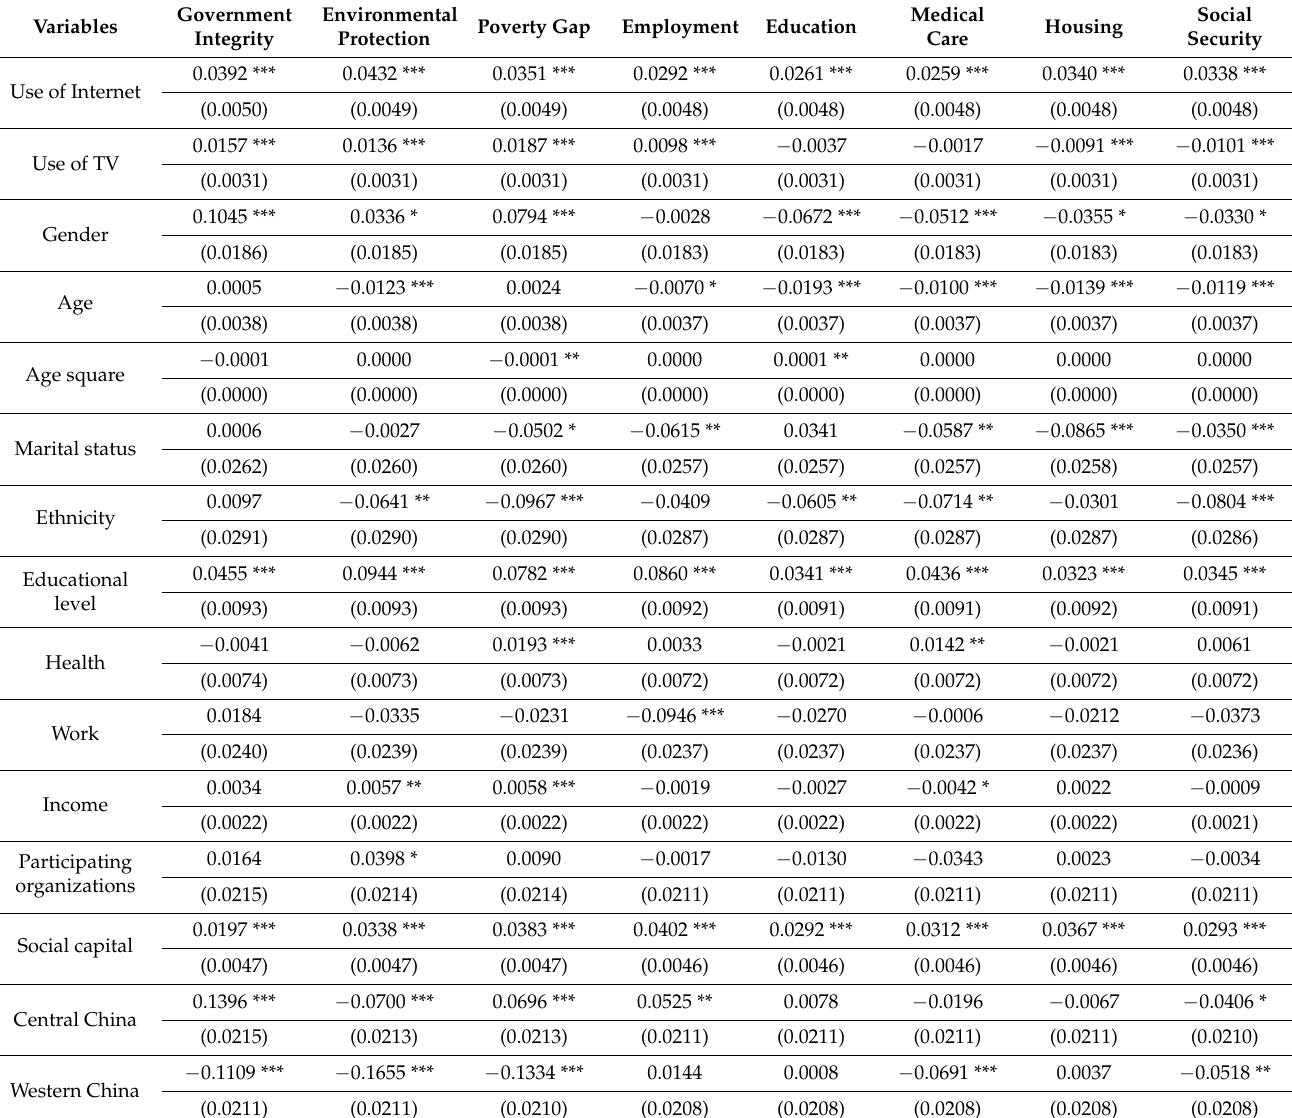
Table 4. Benchmark regression